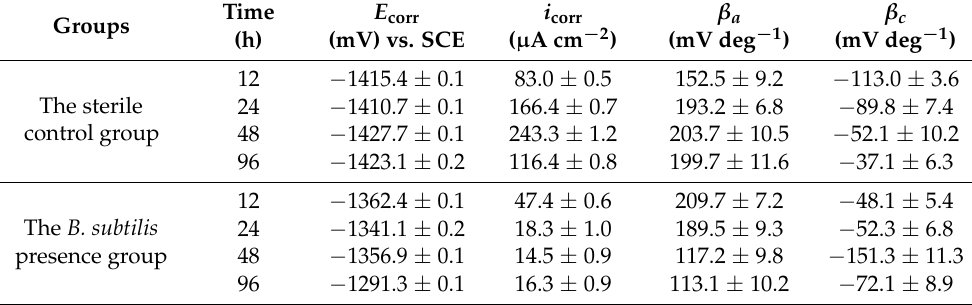
Figure 3. Potentiodynamic polarization curves with immersion time of AZ31B magnesium alloy coupons in the control group and the B. subtilis presence group. ( A ) 12 h; ( B ) 24 h; ( C ) 48 h; ( D ) 96 h. Table 3. Potentiodynamic polarization parameters with immersion time of AZ31B magnesium alloy coupons in the control group and the B. subtilis presence group.